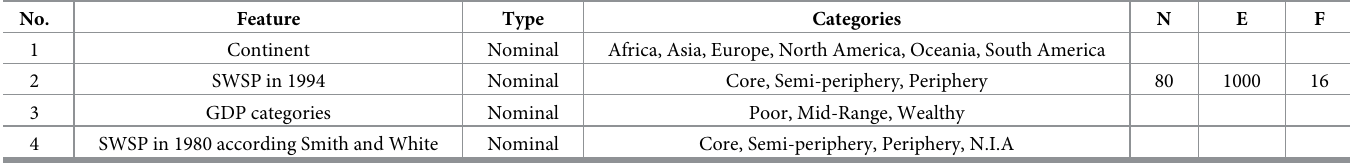
Table 3. Features in World Trade data set. No.